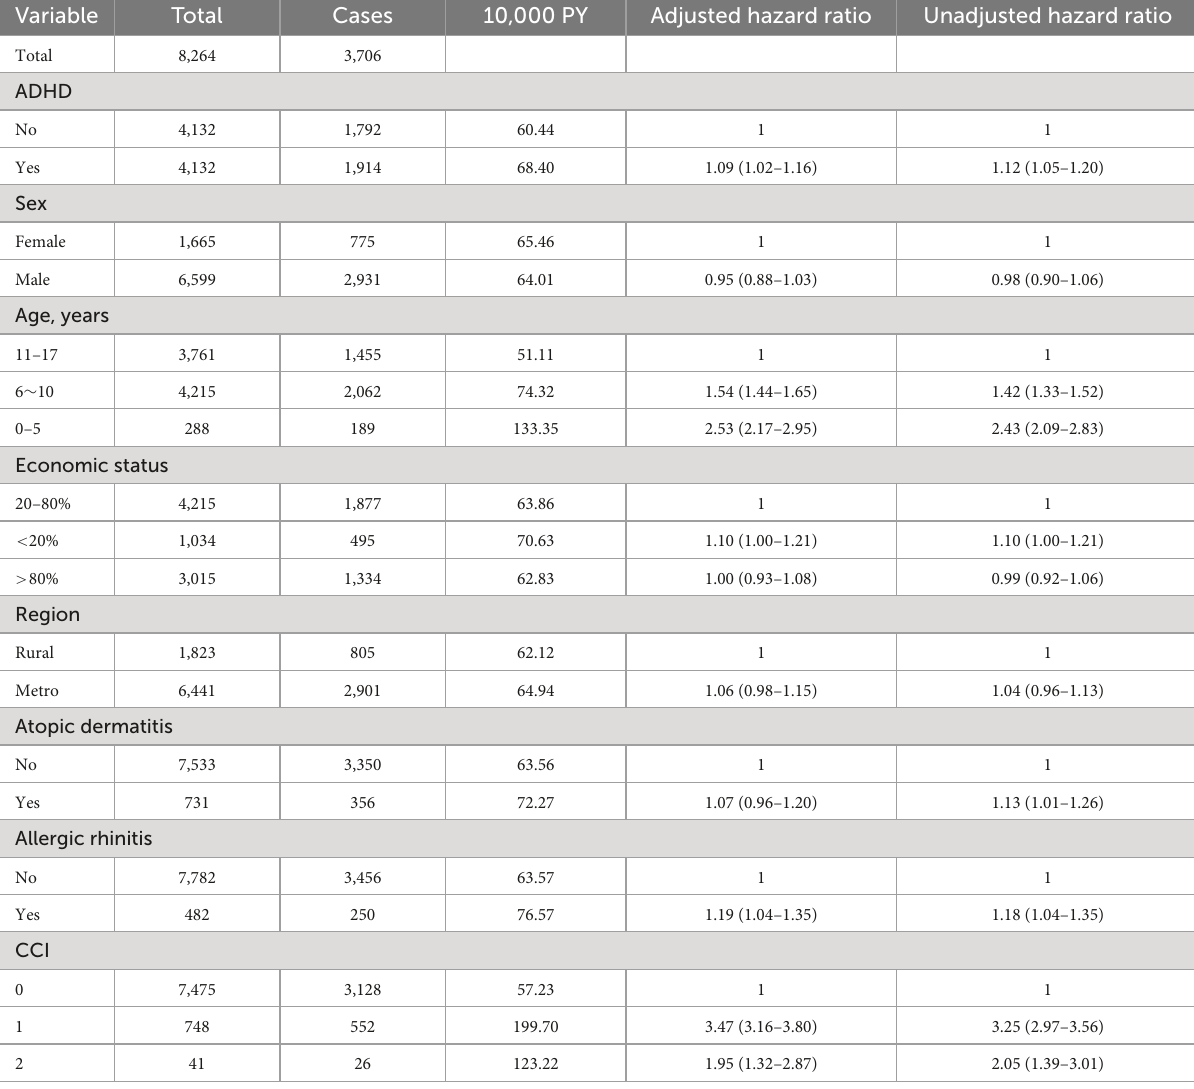
TABLE 4 Incidence rate and adjusted and unadjusted HRs of each group (Study 2).